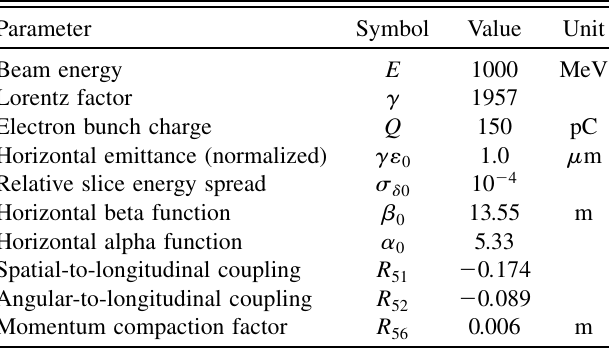
ffiffiffiffiffiffiffiffiffiffiffi p " (cid:1) 0 0 ¼ sin(cid:4) for a single dipole magnet with estimate ( R 51 TABLE I. Parameters given in the magnetic energy spectrome- ter at FLASH and used for the particle tracking